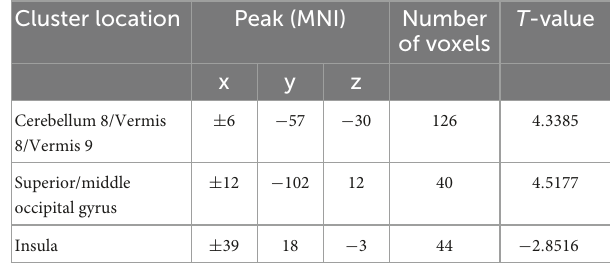
TABLE 1 Regions with abnormal VMHC values in patients with MDD. Cluster location Peak (MNI) Number